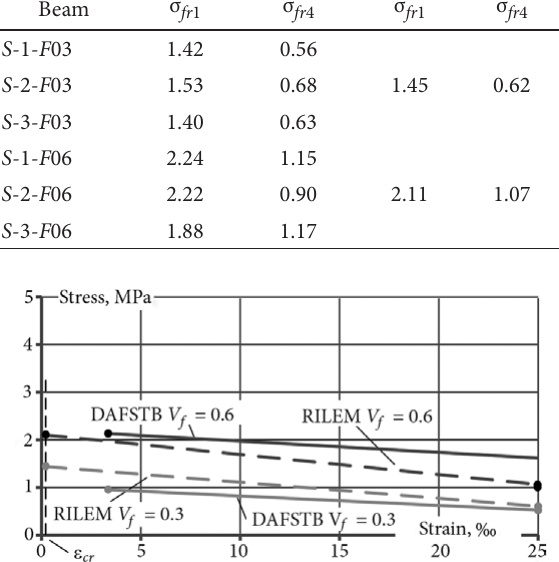
Table 4. Residual strength of the steel fibre reinforced concrete assessed by following the DAfStb methodology in MPa Beam